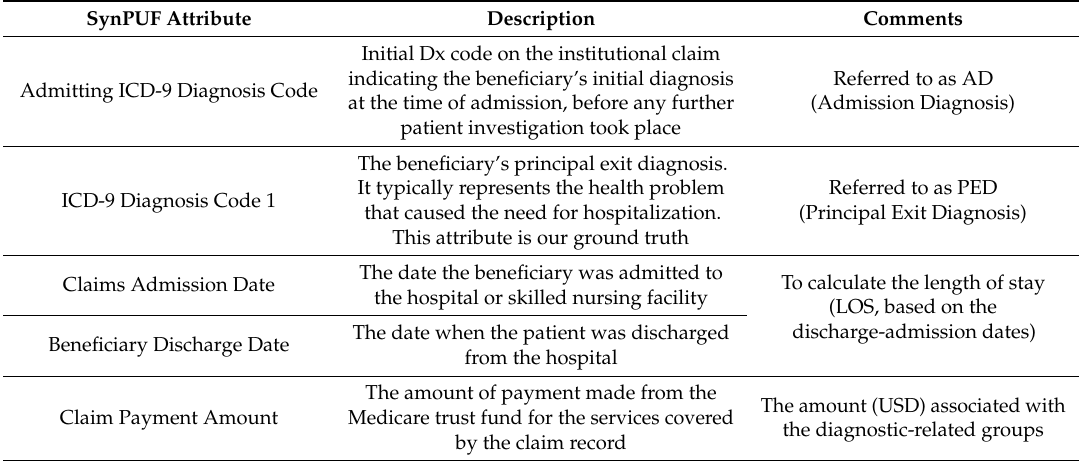
Table 1. Attributes used in this study. ICD: International Classification of